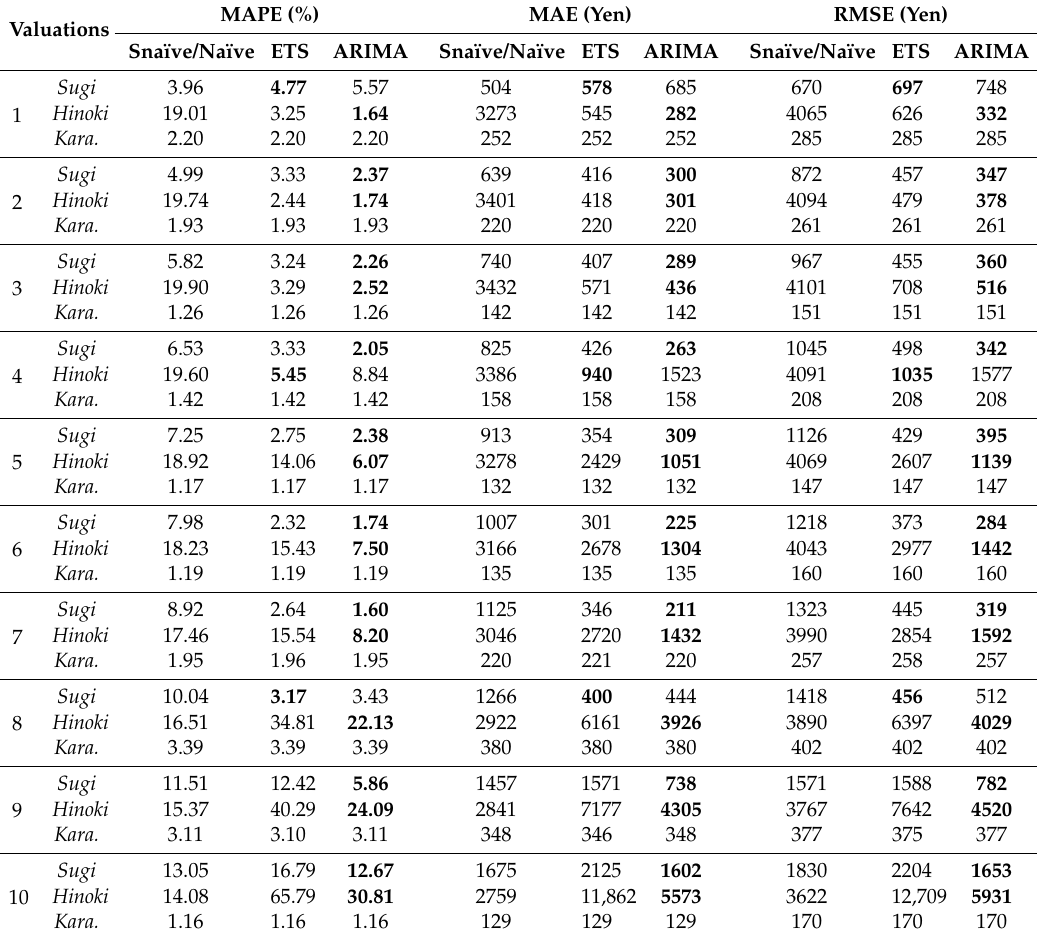
Table 2. Forecast errors for 12-months-ahead forecasts. “ Kara. ” stands for karamatsu . The smallest error among the three methods is shown in bold letters. Snaïve method is applied to sugi and hinoki , while the naïve method to karamatsu. MAPE, mean absolute percentage error; MAE, mean absolute error; RMSE, root mean square